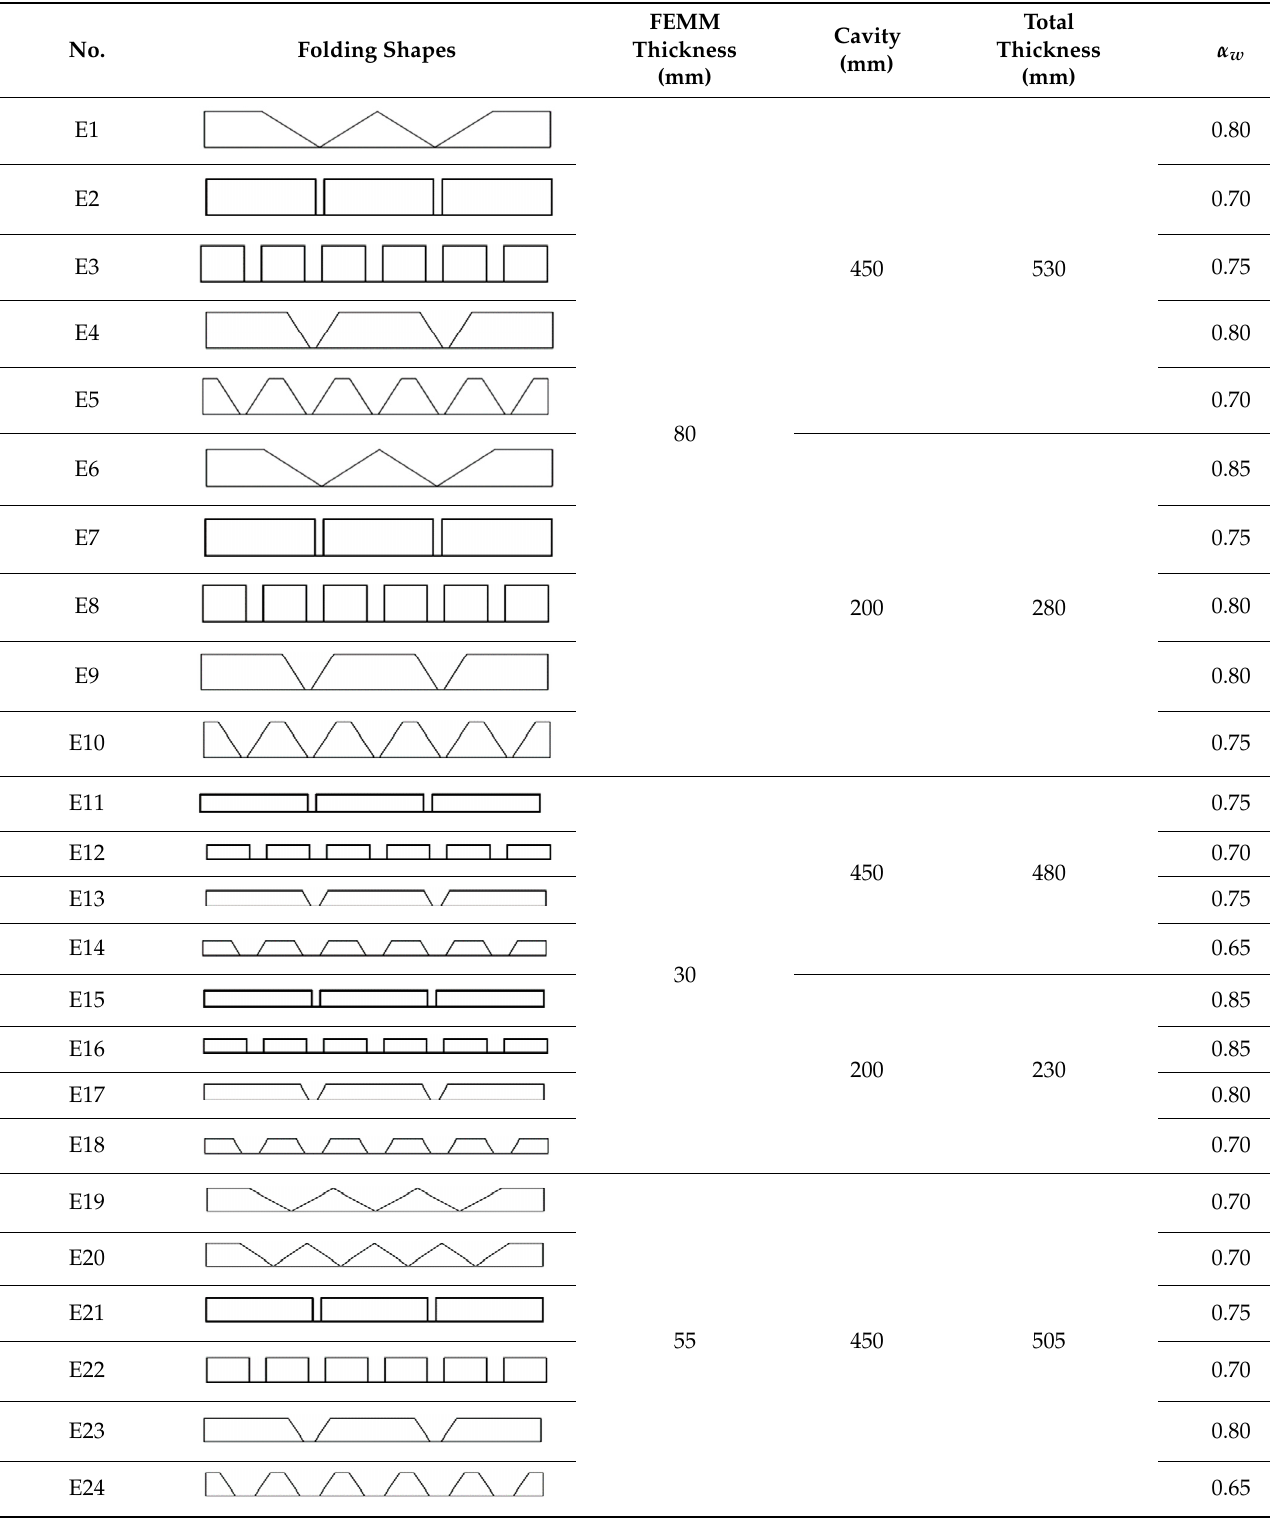
Figure 8. The sound-absorption coefficient of EMM with a 460 mm cavity.